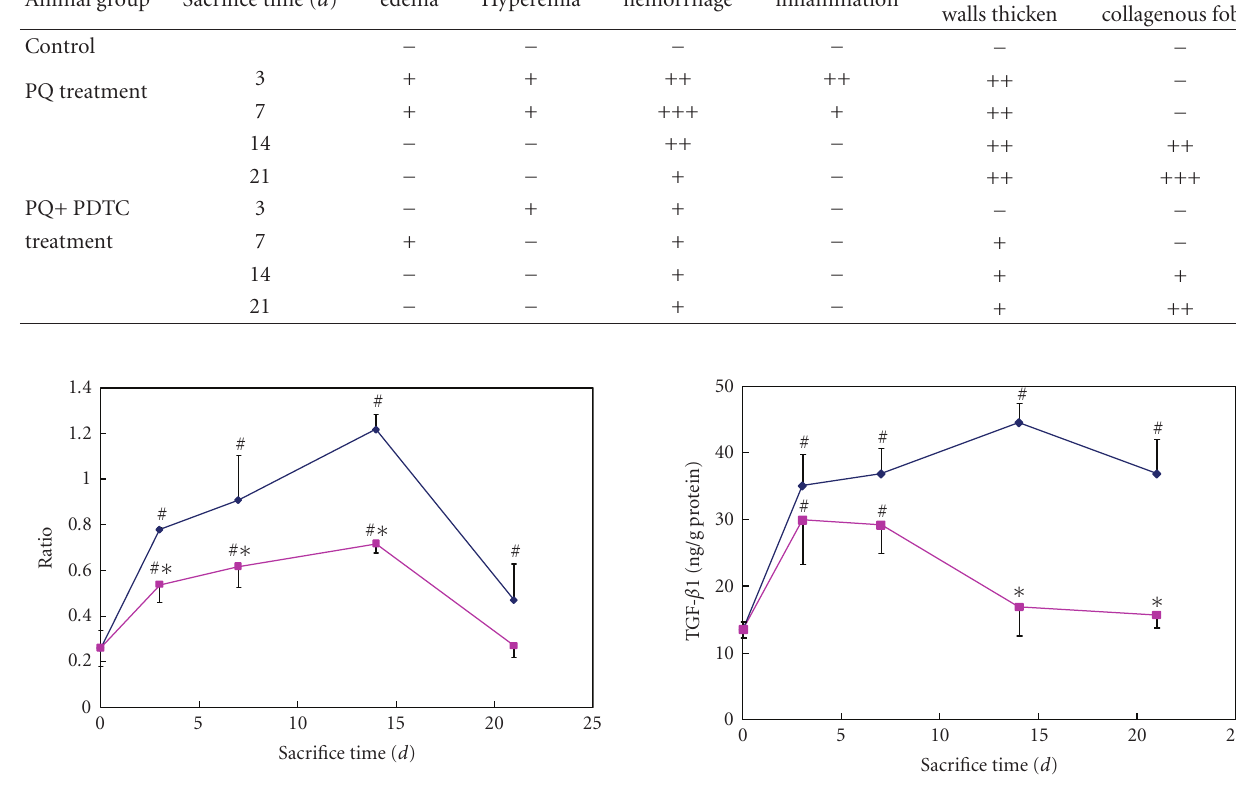
Table 2: Semiquantitative analysis of the morphological injury of lung after PQ or/and PDTC treatment. Animal group Sacrifice time ( d ) edema Hyperemia hemorrhage